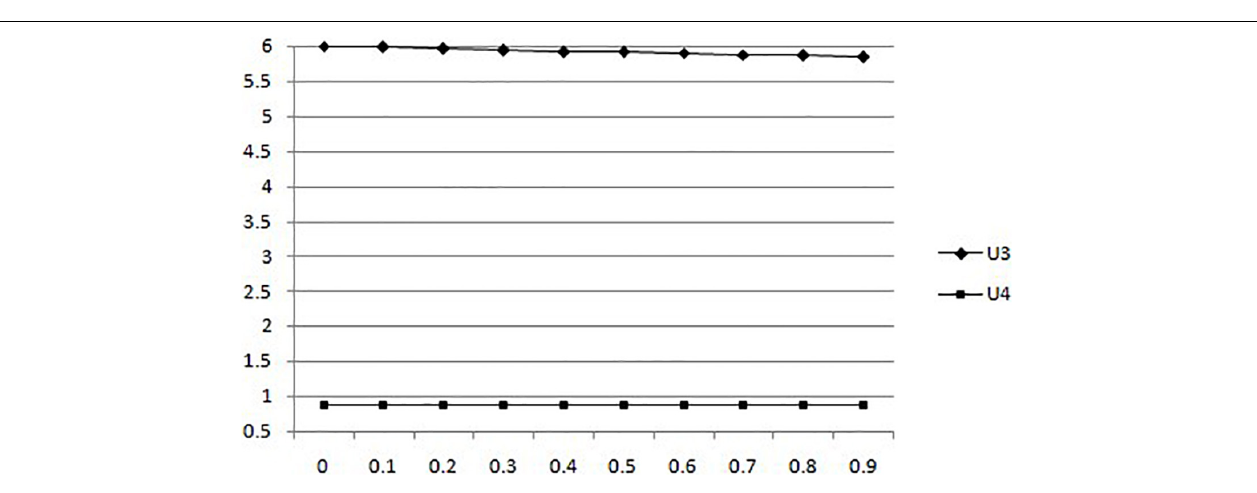
FIGURE 4 | In the situation of government supervision, the changes of expected utility of mobile medical businesses and users with the probability of government